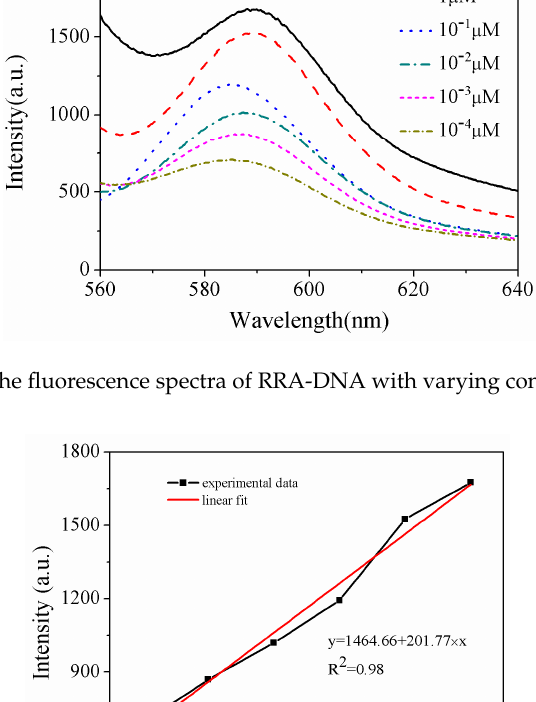
Figure. S1. ( a ) The zoom-in SEM figures of porous silicon microcavity (PSiMC), and ( b ) the hybrid nanostructure of gold nanoparticles (Au NPs) deposited on porous silicon.